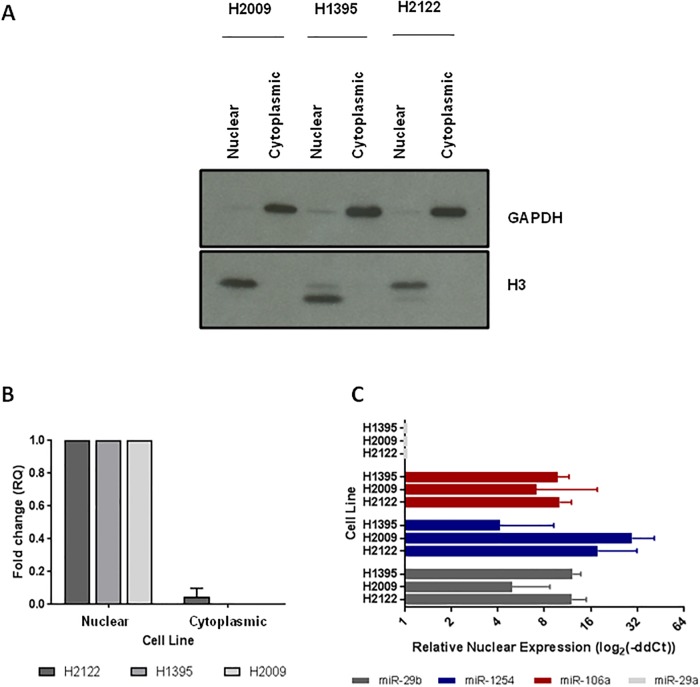
Analysis of XIST-expressing systems reveals XIST-miRNA-DMX gene axes enriched in nuclear miRNA.A) LUAD cell lines were fractionated by subcellular compartment, and the nuclear and cytoplasmic protein fractions showed strong enrichment of H3 and GAPDH, respectively (nuclear and cytoplasmic proteins). B) RT-qPCR of nuclear and cytoplasmic RNA from LUAD cell lines confirms that XIST is present only in the nuclear fraction. C) Similarly, the ratio of miRNA expression in the nuclear and cytoplasmic cell line fractions shows that miR-106a and miR-1254 are enriched in the nucleus at a similar level as miR-29b, a miRNA with a known nuclear localization sequence. This enrichment is not seen in miR-29a, a miRNA with known cytoplasmic localization in its mature form.